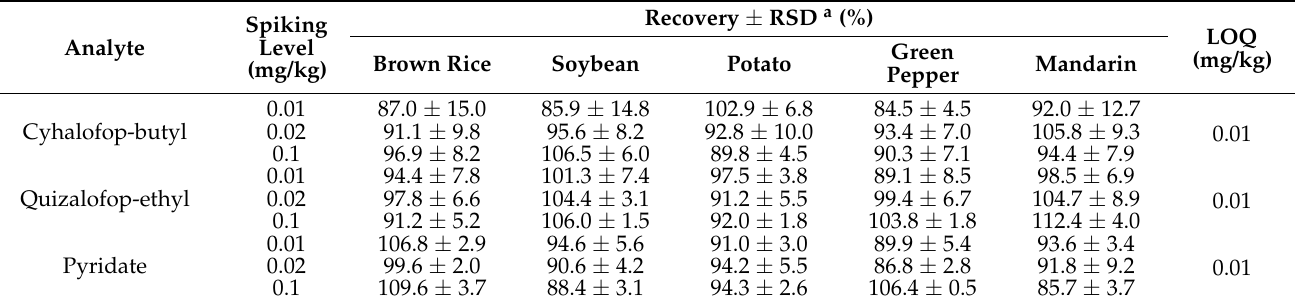
Table 6. Validation results of the proposed analytical method for the determination of three residual herbicides in food samples.